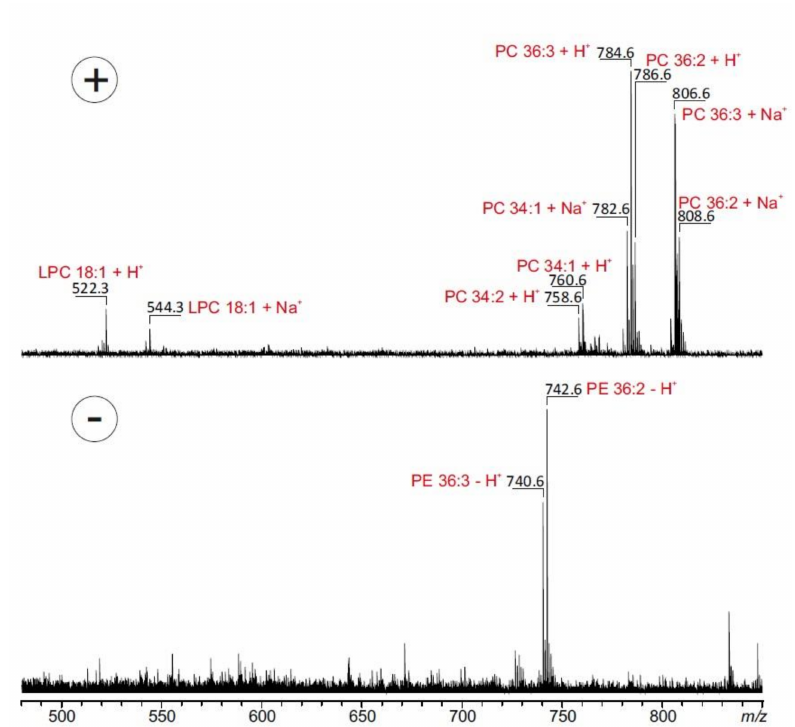
Figure 2. MALDI-TOF mass spectra of ethanolic M. bellicosus extract (soldier caste) collected from Abomey-Calavi. Spectra were recorded in the positive ( upper part) and negative ionization mode ( lower part) in the presence of 2,5-dihydroxybenzoic acid (0.5 M) dissolved in methanol as matrix. The most prominent peaks are assigned to the underlying phospholipid species. Lyso-phosphatidylcholine (LPC), phosphatidylcholine (PC) and phosphatidylethanolamines (PE). Phosphatidylethanolamines (PE) were detected in the negative ion mode at m / z 740.6, 742.6 corresponding to PE 36:2 (18:1 / 18:1 or 18:0 / 18:2) and PE 36:3 (18:1 / 18:2). Fatty acids,